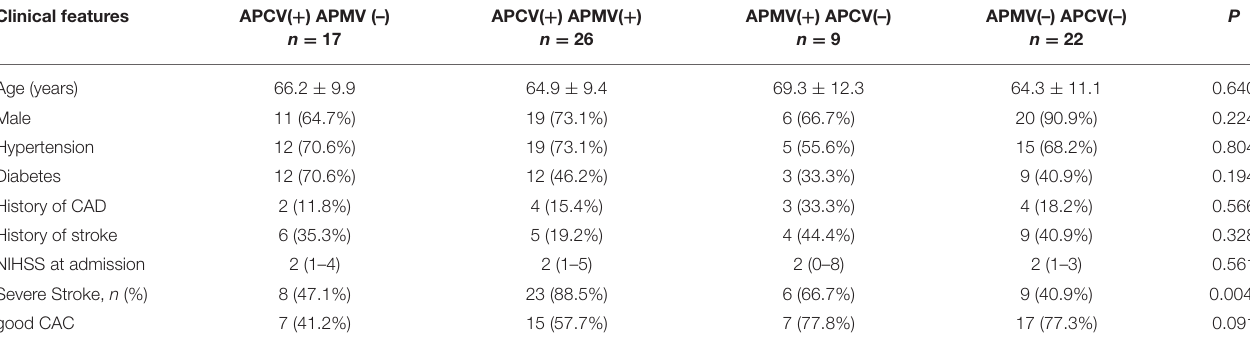
TABLE 5 | Combined analysis of APCV and APMV. Clinical